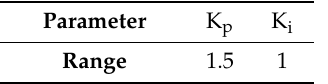
Table 2. Design parameters for PI controller.